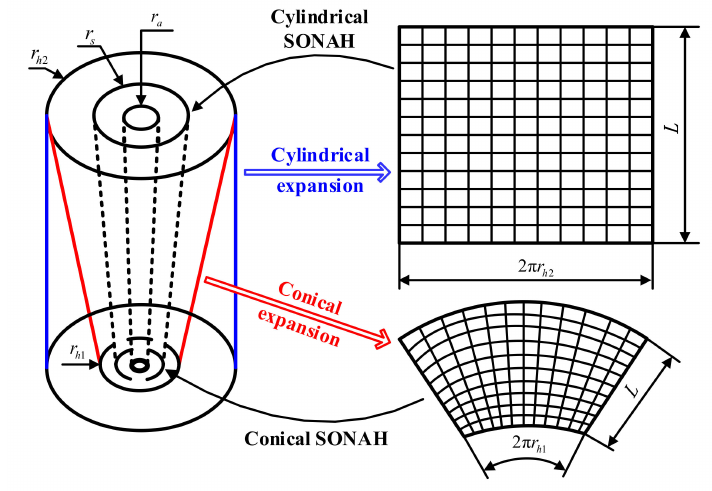
Figure 8. Schematic diagram of the two methods.